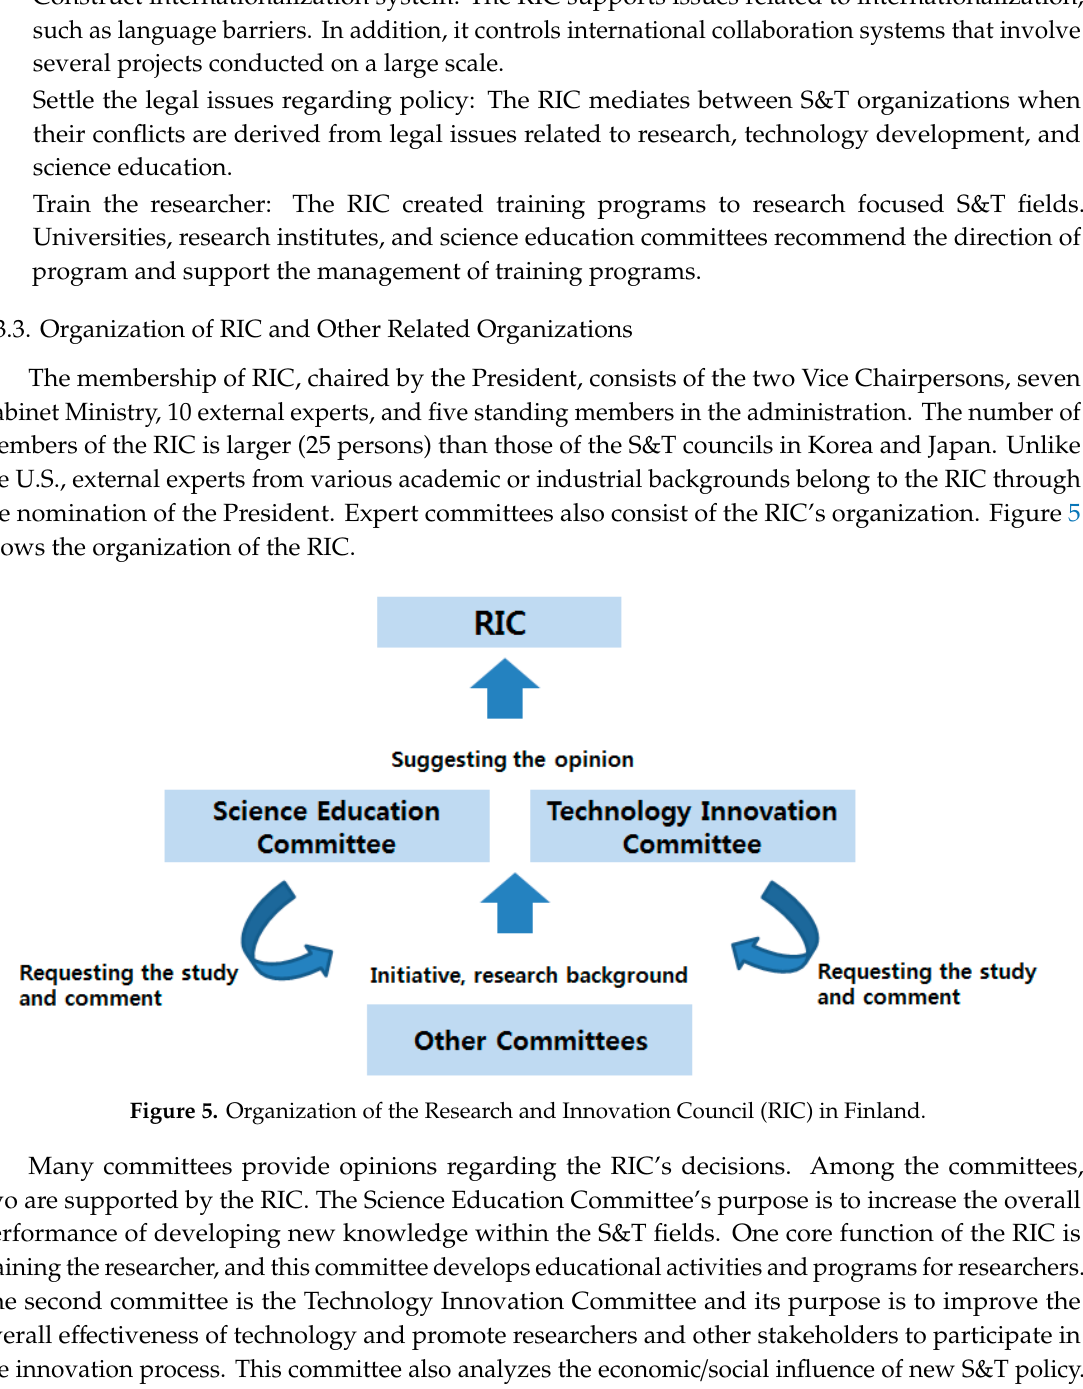
. Figure 6. S&T policy deliberation system in Finland. In addition, the detailed policies of each department are deliberated by the Academy of Finland (AF) and Business Finland. Initially, the AF organization primarily supported fundamental research in universities. However, the AF is also involved in developing advanced research system and environment and maintains a collaboration system between research institutes, universities, and the government. Business Finland was established for the purpose of supporting R&D of companies and universities, providing innovation fund, supporting information on export, investment and tourism, overseas expansion of small and medium companies, and attracting foreign direct investment. Actually, on 1 January 2018, Finpro which is the Finnish trade promotion organization and Tekes which is the Finnish Funding Agency for Innovation were united as Business Finland. Business Finland’s mission is to catalyze new growth and create opportunities for Finland through innovation and international expansion.